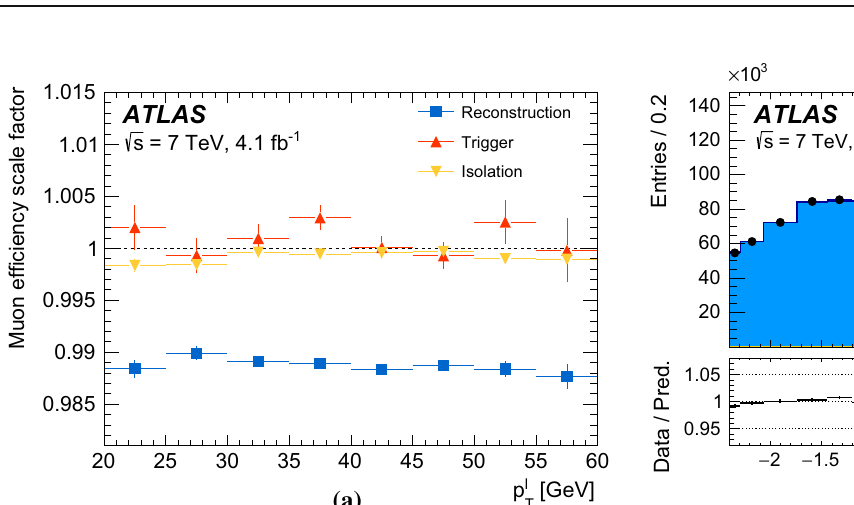
p T -dependence of the corrections is observed in any of the detector